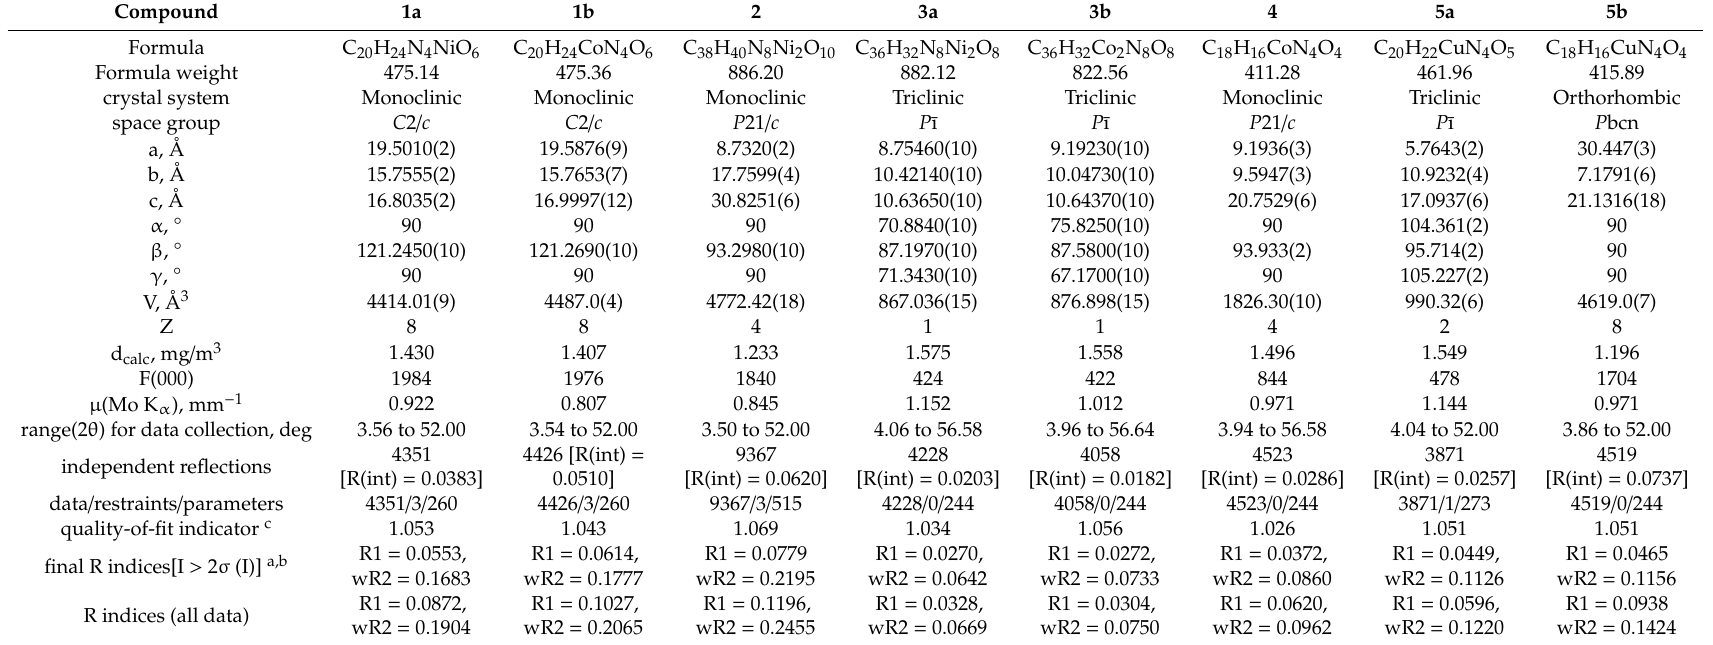
Table 1. Crystal data for complexes 1a – 5b · H 2